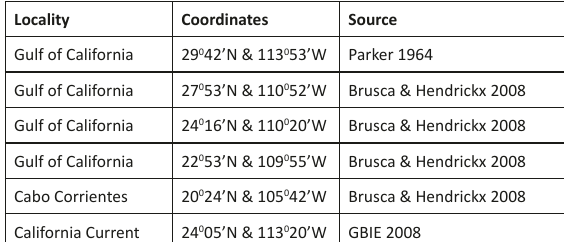
Table 2. Records of Callogorgia flabellum (Ehrenberg, 1834) in the eastern Pacific. Include depth, include gear